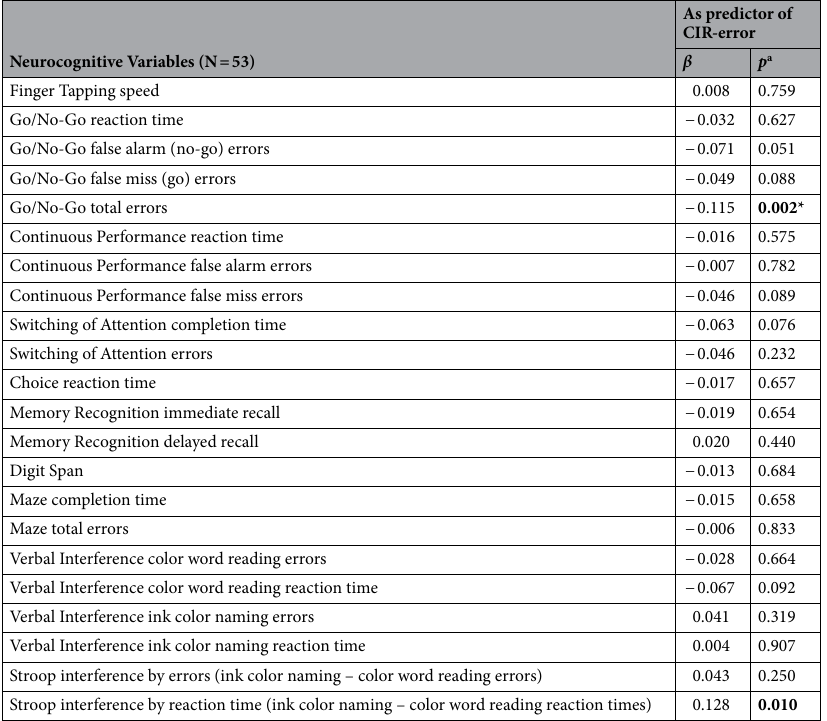
Table 4. Neurocognitive variables as predictors of clutter underreporting (CIR-error). a p values < .0.05 are indicated in bold text. *Meets Bonferroni-corrected alpha threshold of p <